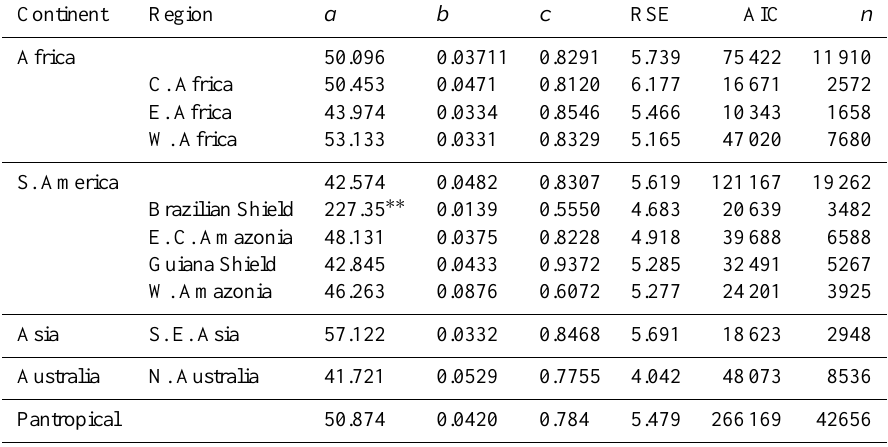
∗ Models adapted from the pantropical tree H : D database of Feldpausch et al. (2011). ∗∗ Although an unrealistic asymptotic maximum H coefficient ( a ), trees of 10 and 160 cm diameter would have an estimated H of 11.1 and 47.2m, respectively, with this